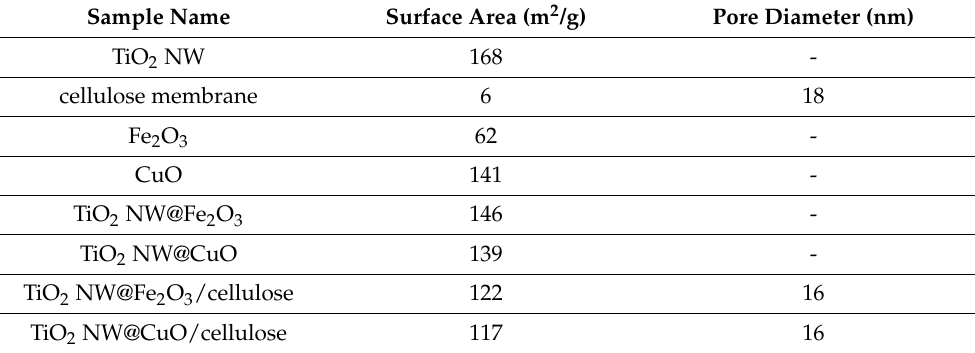
Table 2. Specific surface areas of the pure materials and the hybrid membranes.